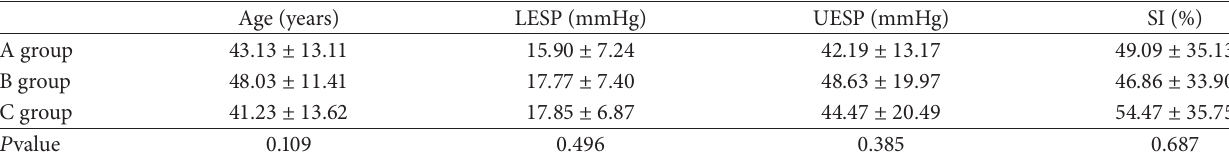
Table 1: Characteristics of three